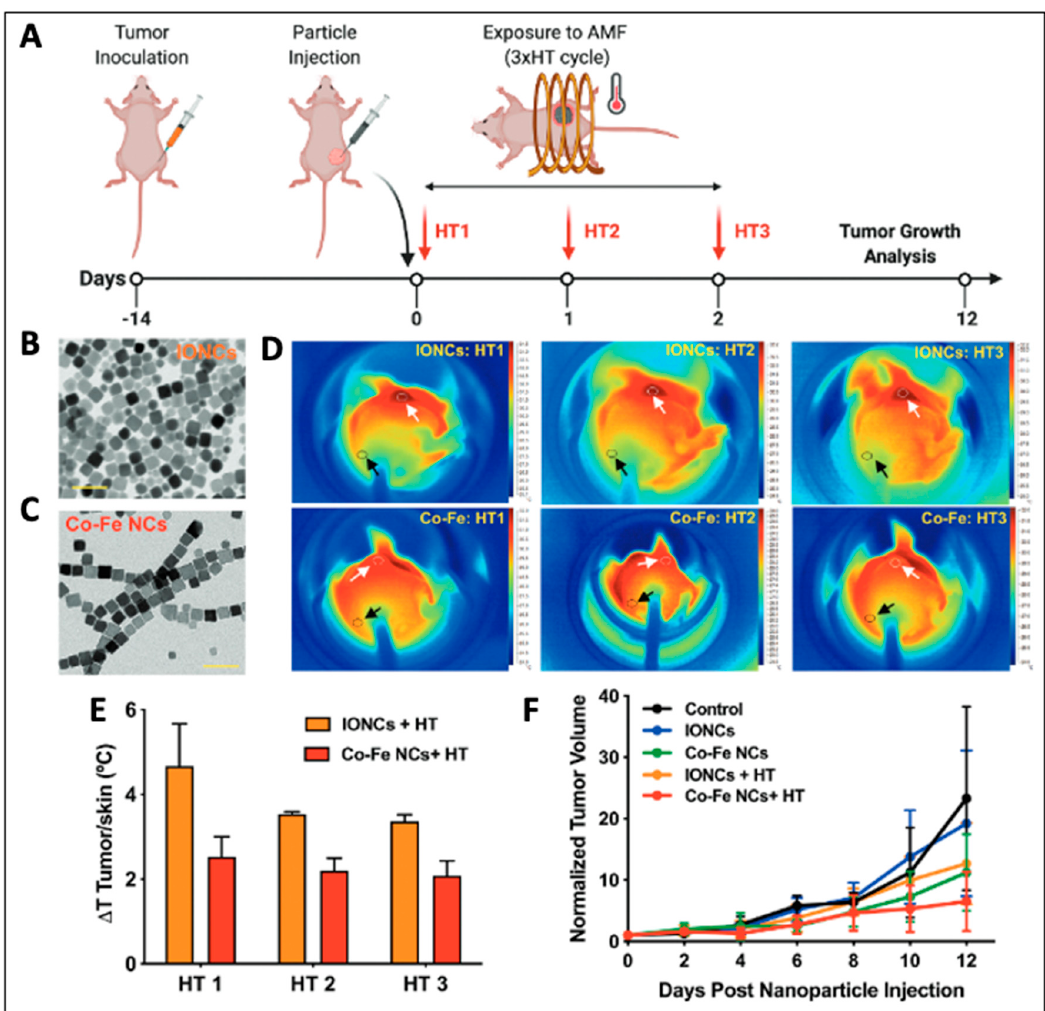
Figure 4. Comparison of in vivo potency of IONC and Co-Fe NC. ( A ) Timeline depiction of treatment strategy adopted. The particles were injected on day 0 (0.7 mg IONCs or 0.7 mg Co-Fe NCs) followed by hyperthermia treatment (HT) using clinically approved AMF (frequency = 110 kHz; field strength = 20 kAm − 1 ). ( B , C ) TEM images of IONCs (18 ± 3 nm) and Co-Fe NCs (17 ± 2 nm), respectively. ( D ) Infrared images of treated mice on days 1, 2, and 3 (HT1, HT2, HT3). Black and white arrows indicate the temperature of the skin (T skin ) and tumor (T tumor ), respectively. ( E ) Δ T plot ( Δ T = T tumor –T skin ). ( F ) The Tumor growth curve indicates a greater reduction in tumor volume for animals treated with Co-Fe NCs. Reproduced with permission from Ref. [108]. Copyright 2020 John Wiley & Sons.